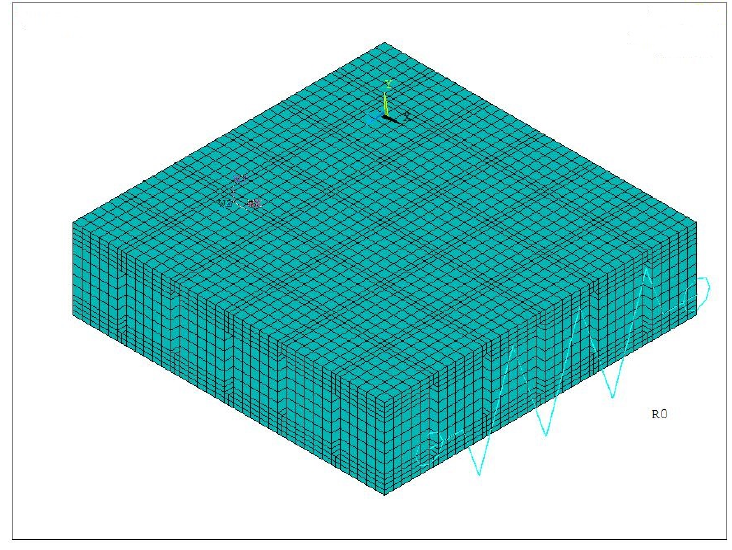
Figure 2. Mesh generation of model.